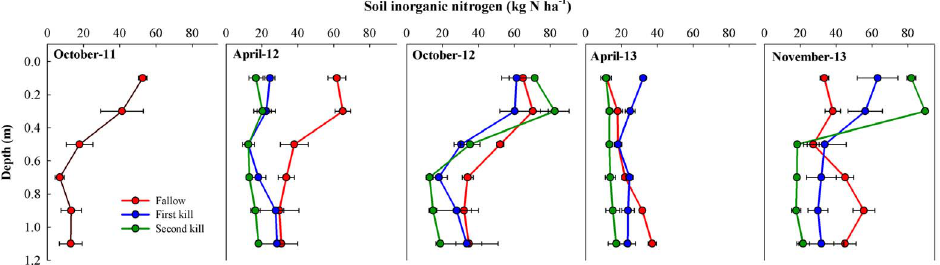
Figure 5. Soil inorganic nitrogen (kg N ha 2 1 ) in the upper 1.2 m of the soil profile for the fallow (Fa), first kill (FK) and second kill (SK) treatments at different sampling